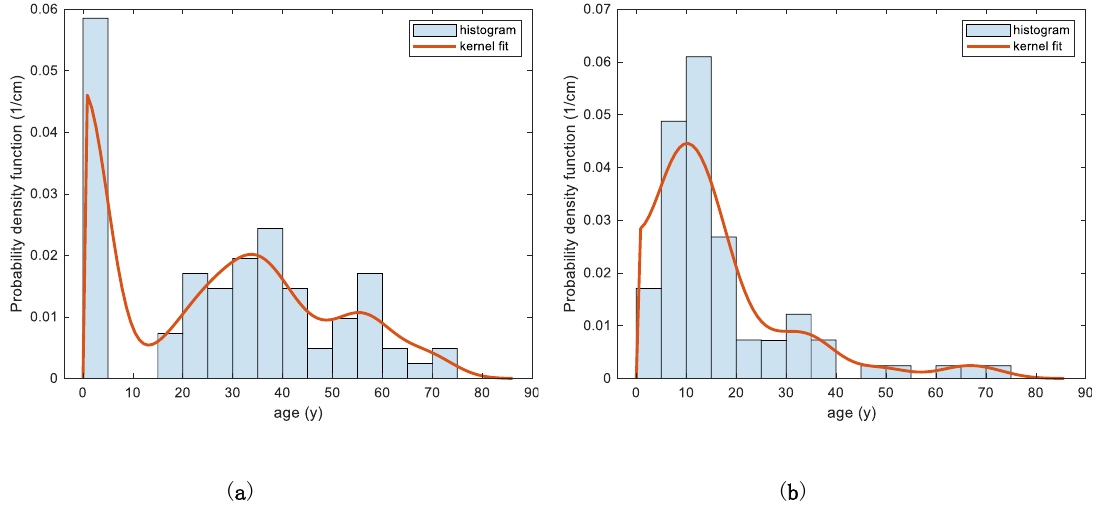
Figure 9. Age-frequency distribution of the Eunicella verrucosa population monitored off Sanremo, by model. ( a ) Model A; ( b ) Model B. The histograms have been normalized to become comparable with the estimated probability density function. The bin width of the histogram and the bandwidth of the Gaussian kernel are both set to 5 years. Table 2. Age statistics for the Eunicella verrucosa population monitored off Sanremo, y = years. Mean (y)